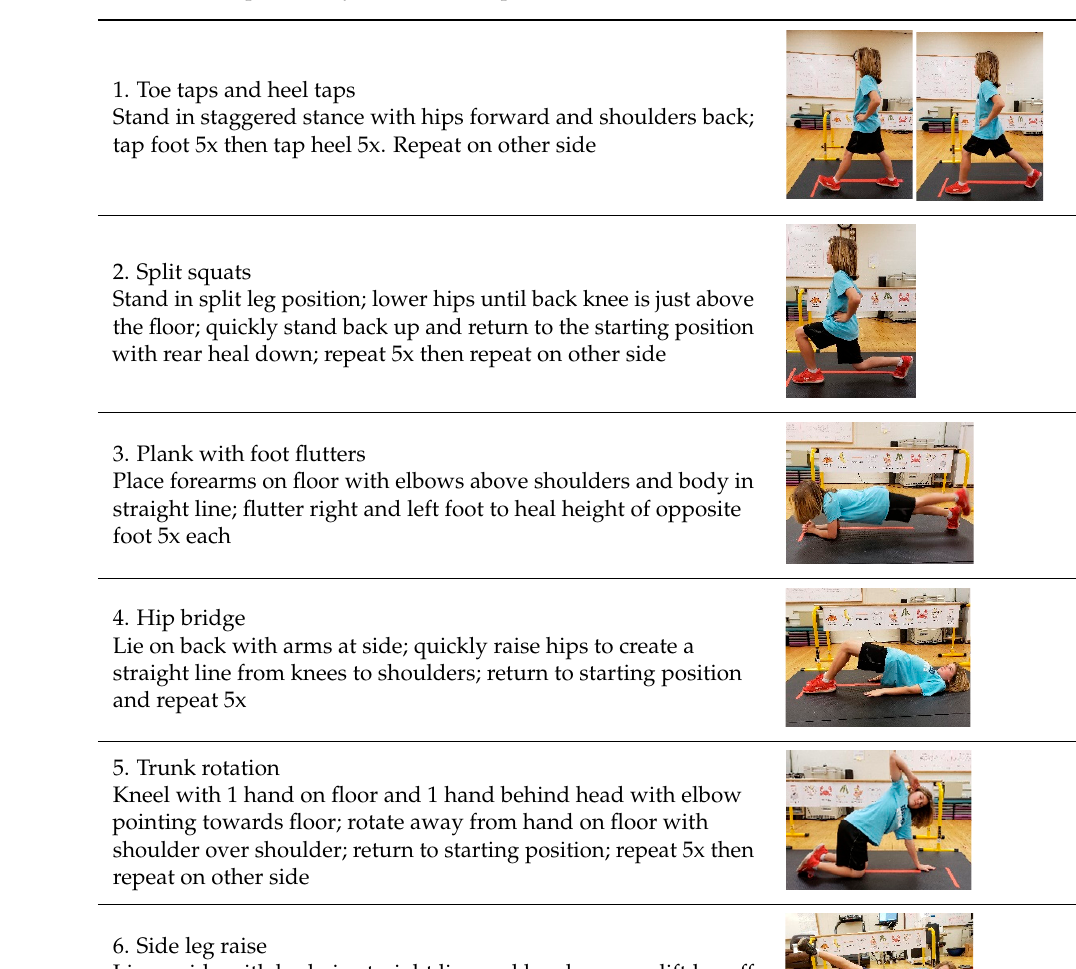
Table 1. Description of dynamic warm-up exercises.